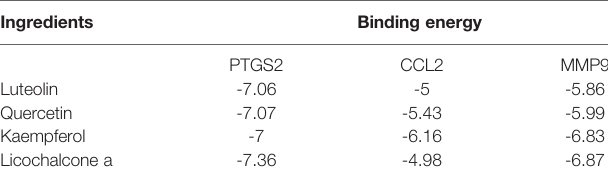
TABLE 3 | Virtual docking of four important active compounds in QYSLS to adverse skin reaction targets. Ingredients Binding